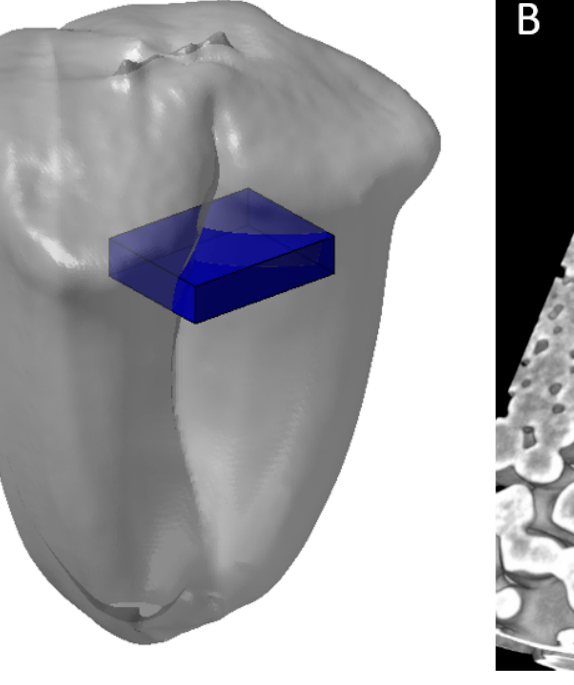
Figure 7. Representative example of the inter connections of empty spaces between cells within ventral mesocarp of a wheat caryopsis at 100 °DAA. ( A ) Localization of the region observed. ( B ) A 2D projection of a 3D view .